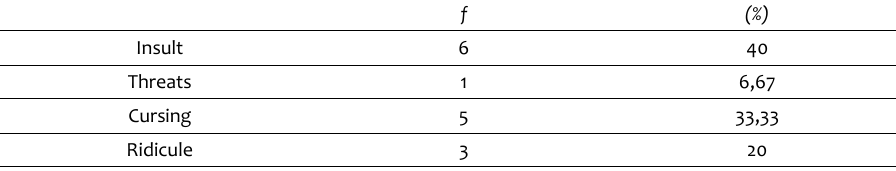
Table 3. Forms of violent communication among peers before the research f (%) Insult 6 40 Threats